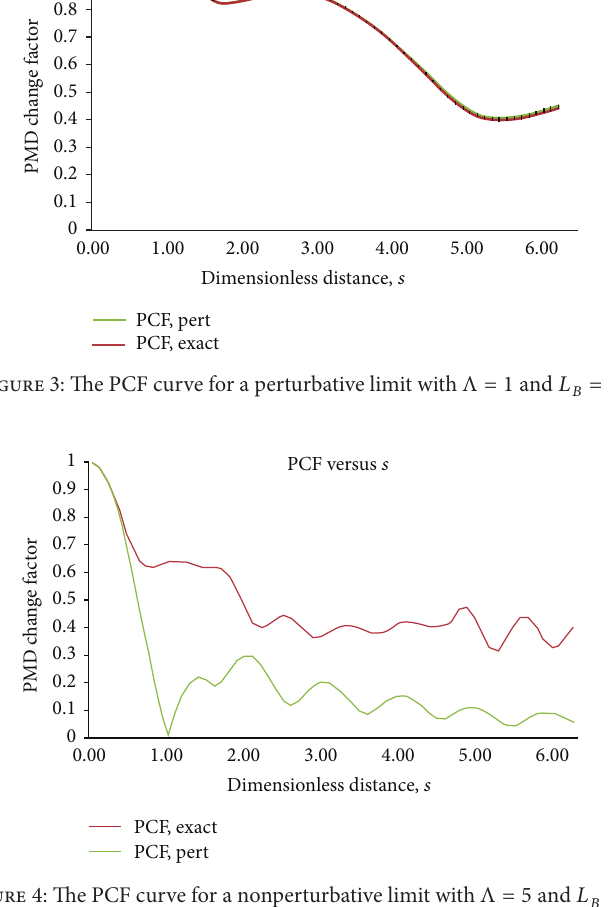
The top and bottom curves in Figure 5 show exact and perturbative calculations, respectively. It is seen that pertur- bative approximation underestimates the PCF in this regime. The two start diverging significantly for value of 𝑠 a little beyond